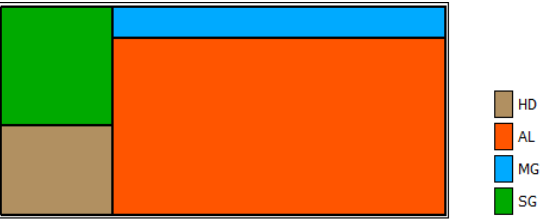
Figure 7. Unfolded domain with HD proportions (%).